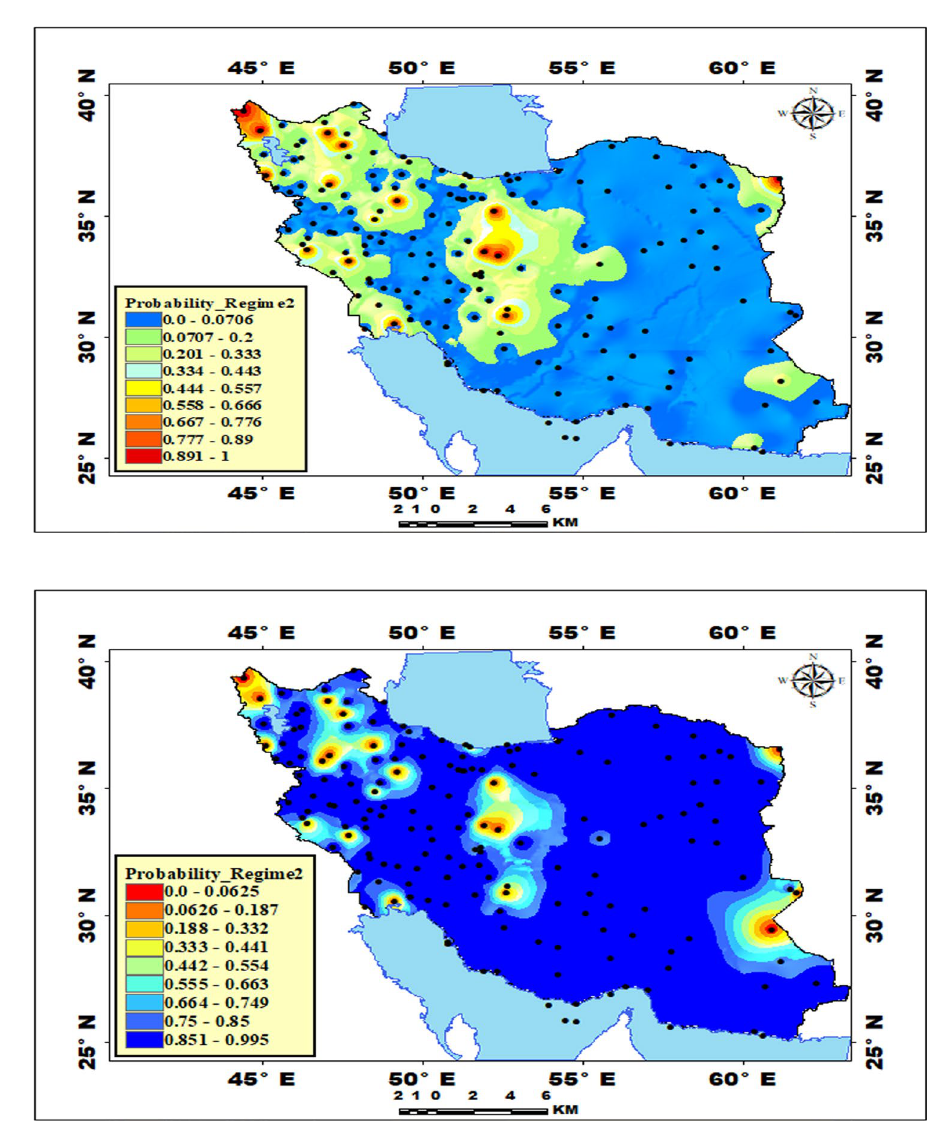
Fig. 6 The probability of the daily rainfall reoccurrence based on the regime1 model